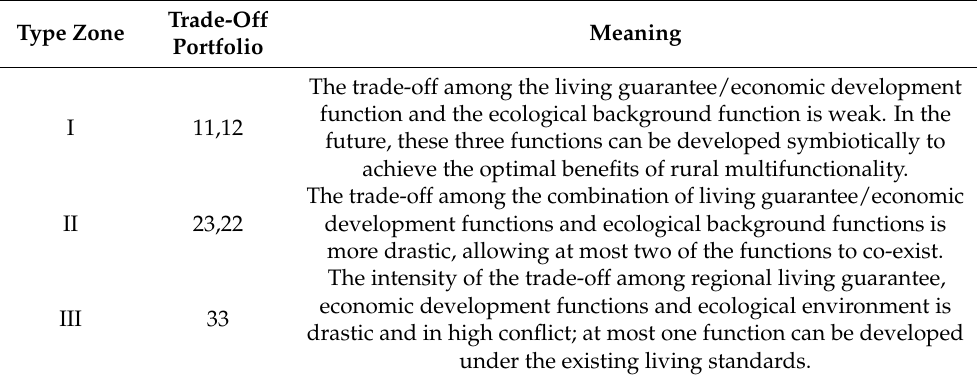
Table 3. Combination of trade-offs between rural functions and implications.